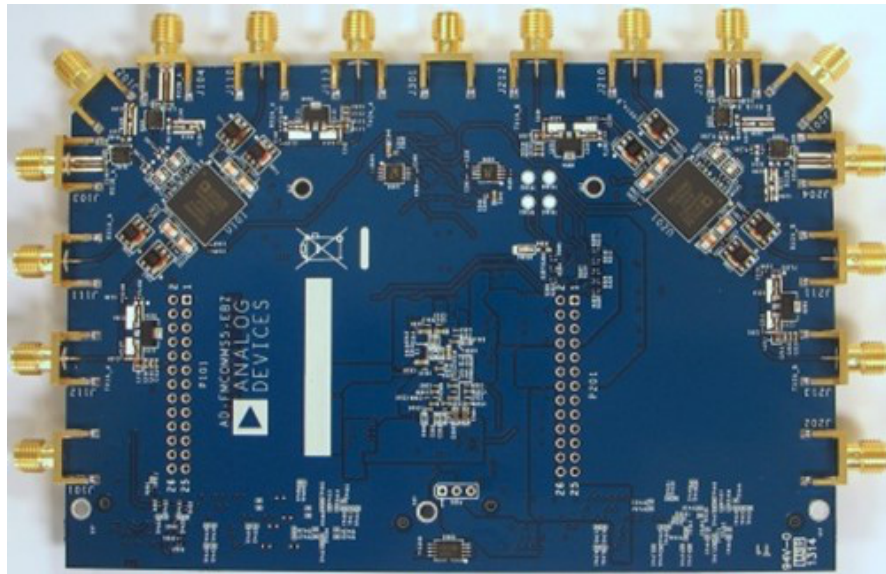
Figure 8. Analog Devices FMCOMMS5 RF evaluation board [87].